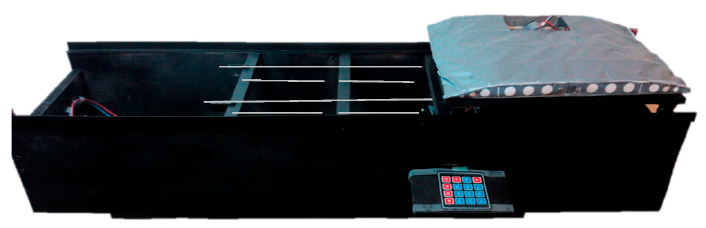
Figure 6. Tensioned elements mechanism prototype.